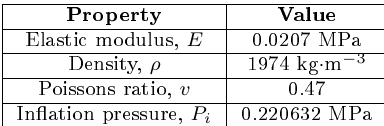
Tab. 3: Results generated from the mesh convergence analysis.